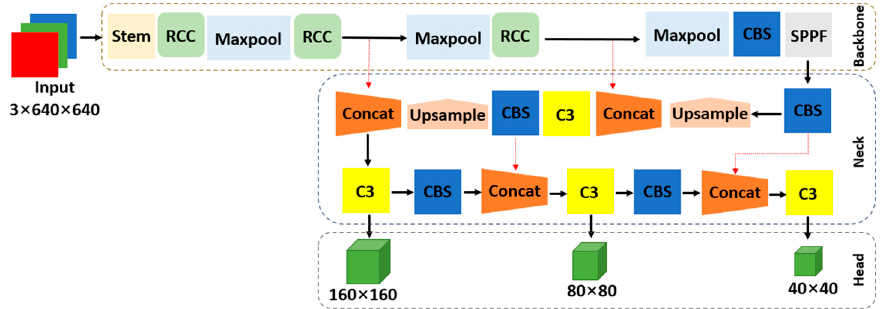
Figure 2. The entire network structure of the YOLO-Jujube method.